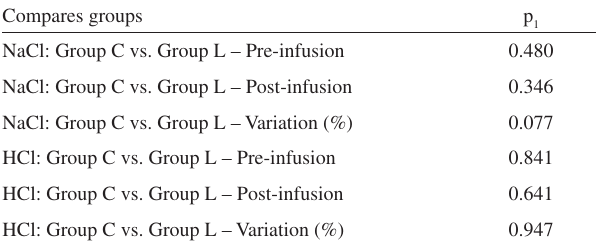
Table 3 - Comparison between the electron microscopy (morphometric analysis) results for patients group “L” and “C” by infusion type